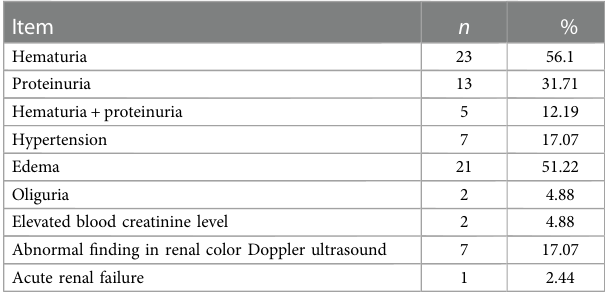
TABLE 1 Manifestations of renal damage in 41 pediatric patients with acute EBV